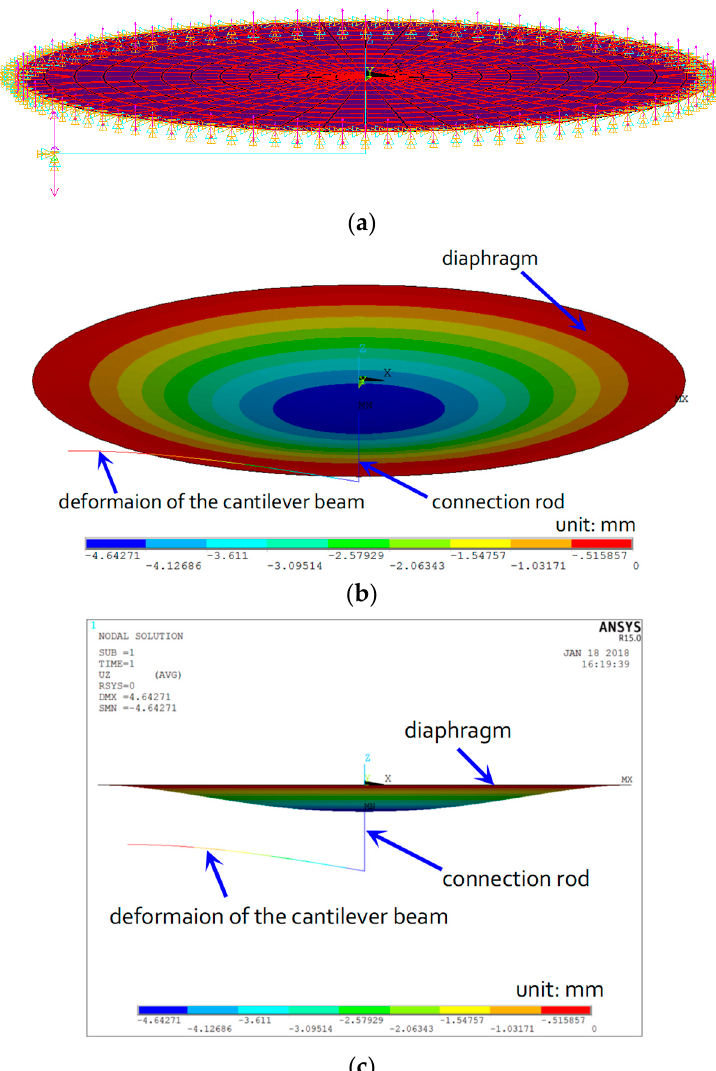
Figure 5. Simulation results of diaphragm and cantilever beam under external pressure of 200 kPa: ( a ) boundary conditions of the FEM model; ( b ) vertical deformation of the diaphragm; ( c ) vertical deformation of the diaphragm and the cantilever beam.